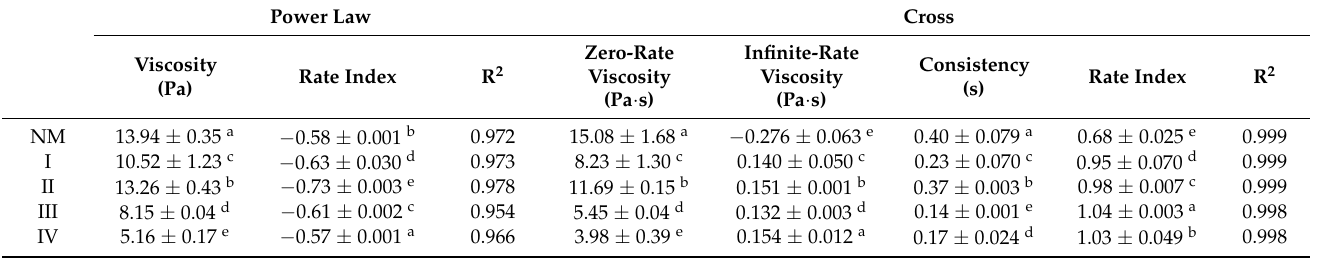
Table 5. The model parameters fitting results of flow behavior of native oats and in four extrusion sections. Power Law